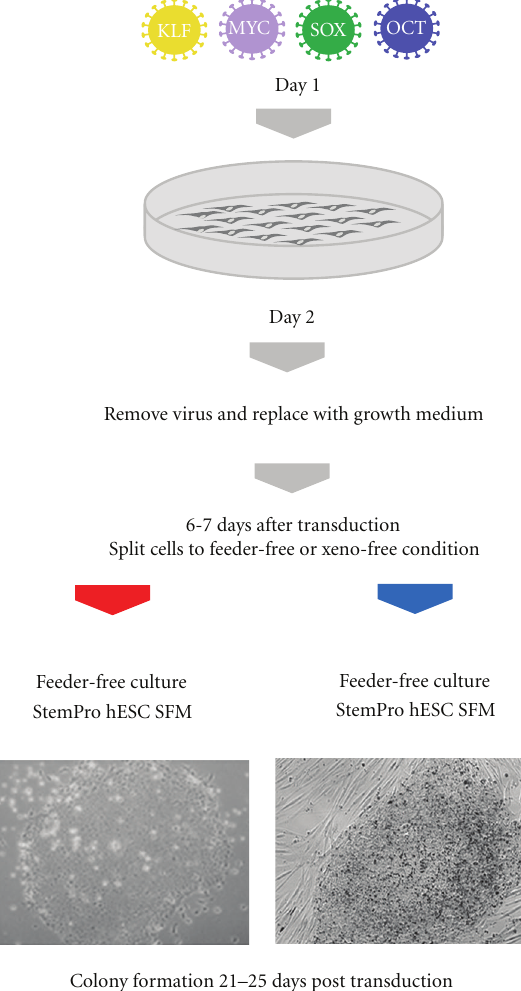
Figure 1: Reprogramming workflow on feeder-free and xeno- free conditions. (1) Transduce cells with CytoTune Sendai virus vector overnight. (2) Remove virus and replace with cell’s growth medium. Cells are grown in cell’s growth medium for 6-7 days after transduction. (3) Split cells onto Geltrex-coated plates or inactivated human feeders. Culture transduced cells in feeder-free conditions with StemPro hESC SFM medium and Geltrex-coated plates or xeno-free medium consisting of KnockOut-DMEM/F-12, 15% KnockOut-SR Xeno-Free CTS, and 1X KnockOut SR Xeno- Free Growth Factor Cocktail. Colonies can be picked between 17–25 days after